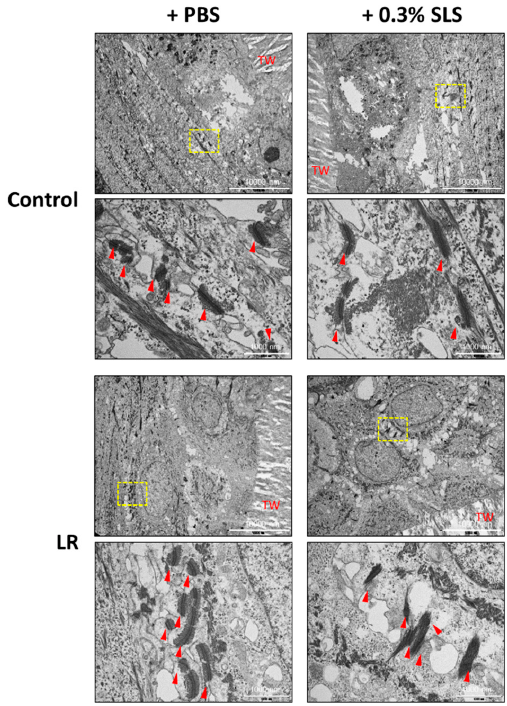
Figure 7. Protective effect of LR on desmosomes in Keraskin TM . LR lysate was topically applied to Keraskin TM every other day 4 times and the images of desmosomes in Keraskin TM were measured by TEM. Yellow dotted box indicated the region of higher magnification. Red arrow; desmosome. TW; Transwell